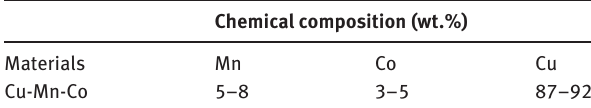
Table 1: Chemical composition of the Cu-Mn-Co brazing filler metal.